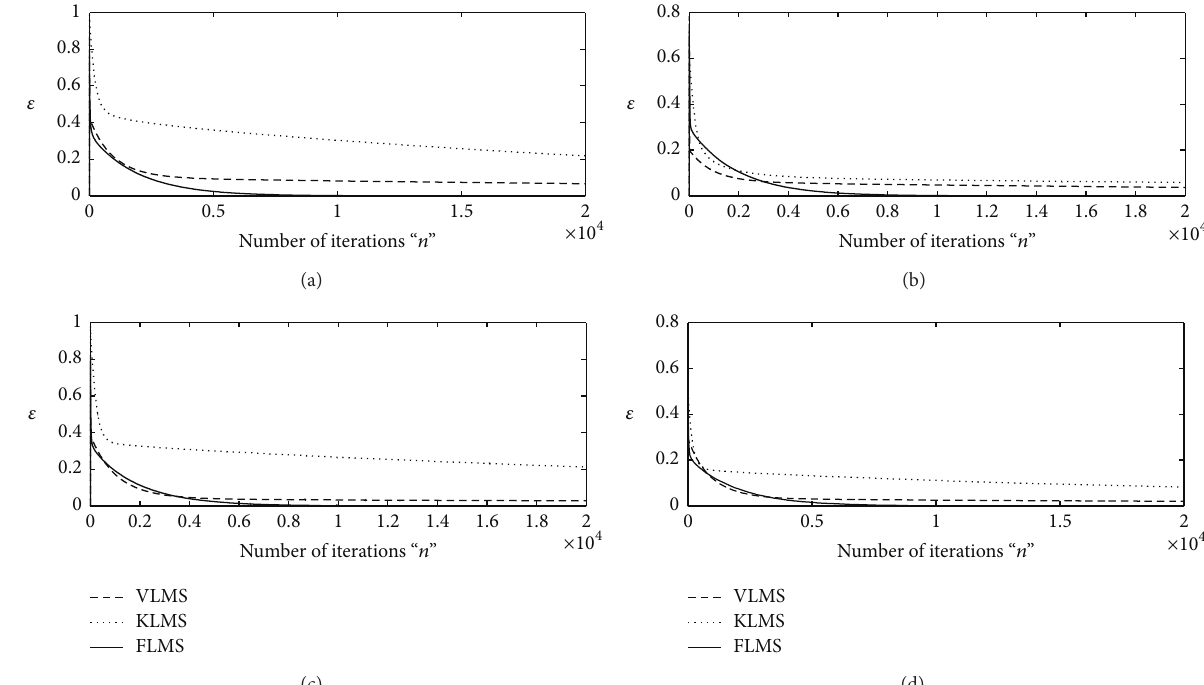
Figure 1: Iterative adaptation of merit function by VLMS, KLMS, and FLMS for fr = 0.5 algorithms for 𝜇 ∈ (10 −04 , 10 −08 ); (a) for SNR = 30 dB, (b) for SNR = 20dB, (c) for SNR = 10, and (d) for SNR = 3dB.